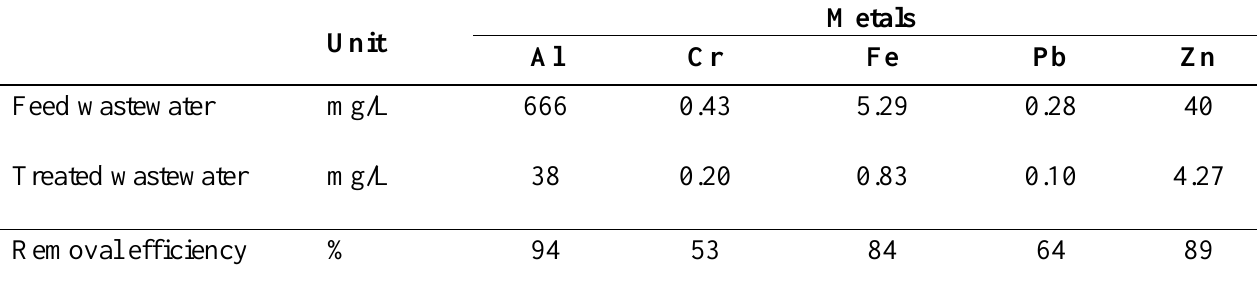
Table 4. Removal efficiency of metals from aqueous waste streams by the carbonation treatment (modified from Enick et al .